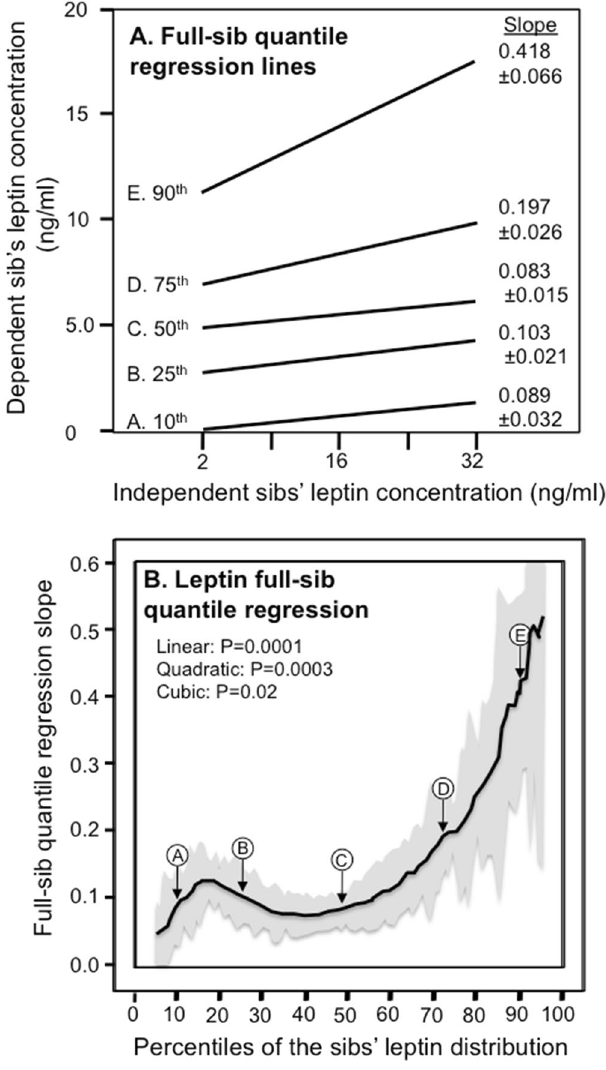
Figure 1. ( A ) Full sib regression slopes (β FS ) for selected quantiles of the leptin concentrations from 3068 siblings in 1133 sibships. The slopes became progressively greater (i.e., steeper) at higher quantiles of the leptin distribution (i.e., > 50th percentile). ( B ) The selected quantile-specific regression slopes from the upper panel were included with those of other quantiles to create the quantile-specific β FS function. Significance of the linear, quadratic and cubic trends and the 95% confidence intervals (shaded region) determined by 1000 bootstrap